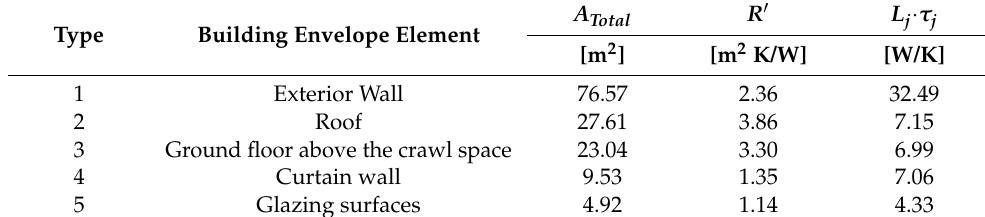
Table 5. The thermal coupling coefficient value ( L ) per element j .